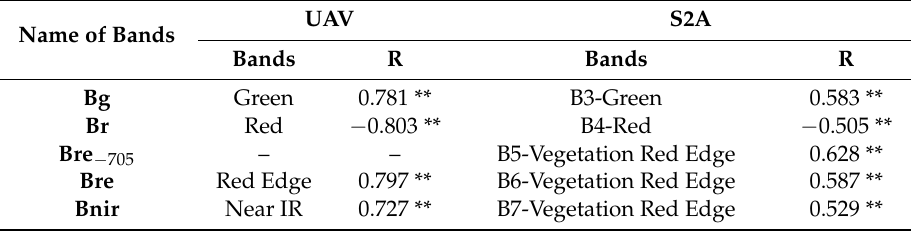
Table 3. Correlation between spectral reflectance of UAV and S2A imagery with SPAD values.